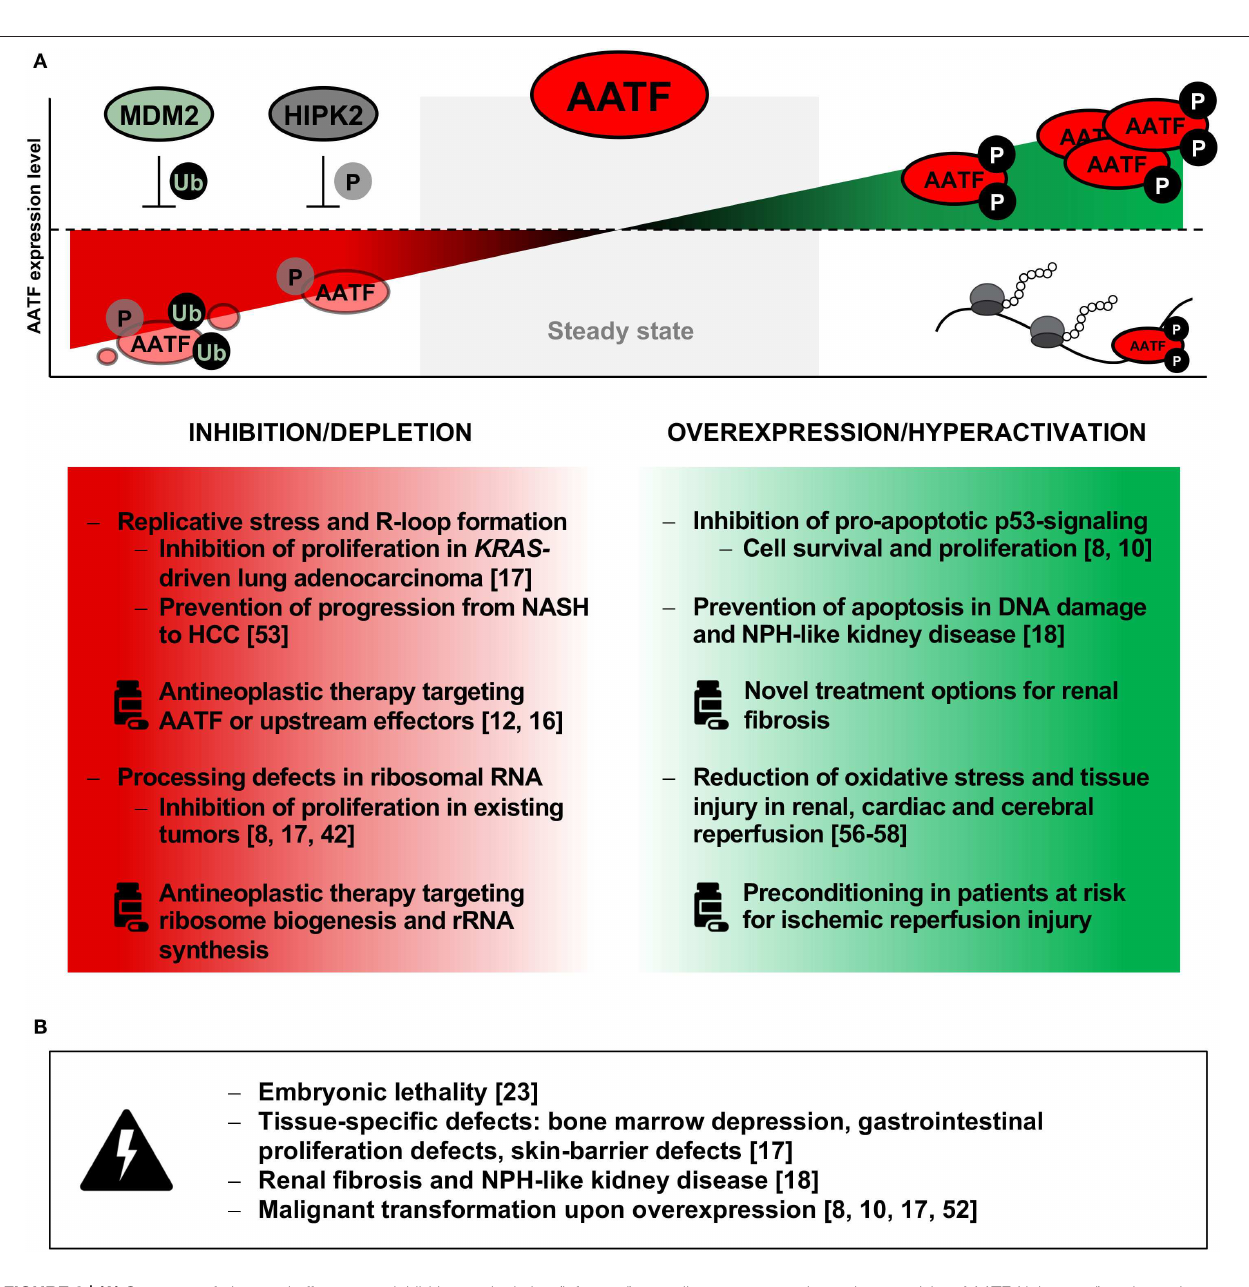
FIGURE 2 | (A) Summary of observed effects upon inhibition or depletion (left panel) as well as overexpression or hyperactivity of AATF (right panel) and putative therapeutic approaches on modulating AATF. Possible treatment opportunities include degradation of AATF by targeting upstream inhibitors such as HIPK2 (phosphorylation) or MDM2 (ubiquitination), while hyperactivity of phosphorylated AATF may lead to increase in RNA binding and ribosome density with subsequent increase in proliferative activity. (B) Possible adverse events upon interference with AATF activity as deducted from available data are listed in the bottom panel. HCC, hepatocellular carcinoma; HIPK2, Homeodomain-interacting protein kinase 2; MDM2, mouse double-minute homolog 2; NASH, non-alcoholic steatosis hepatitis; NPH, nephronophthisis; P, phosphorylation; Ub,